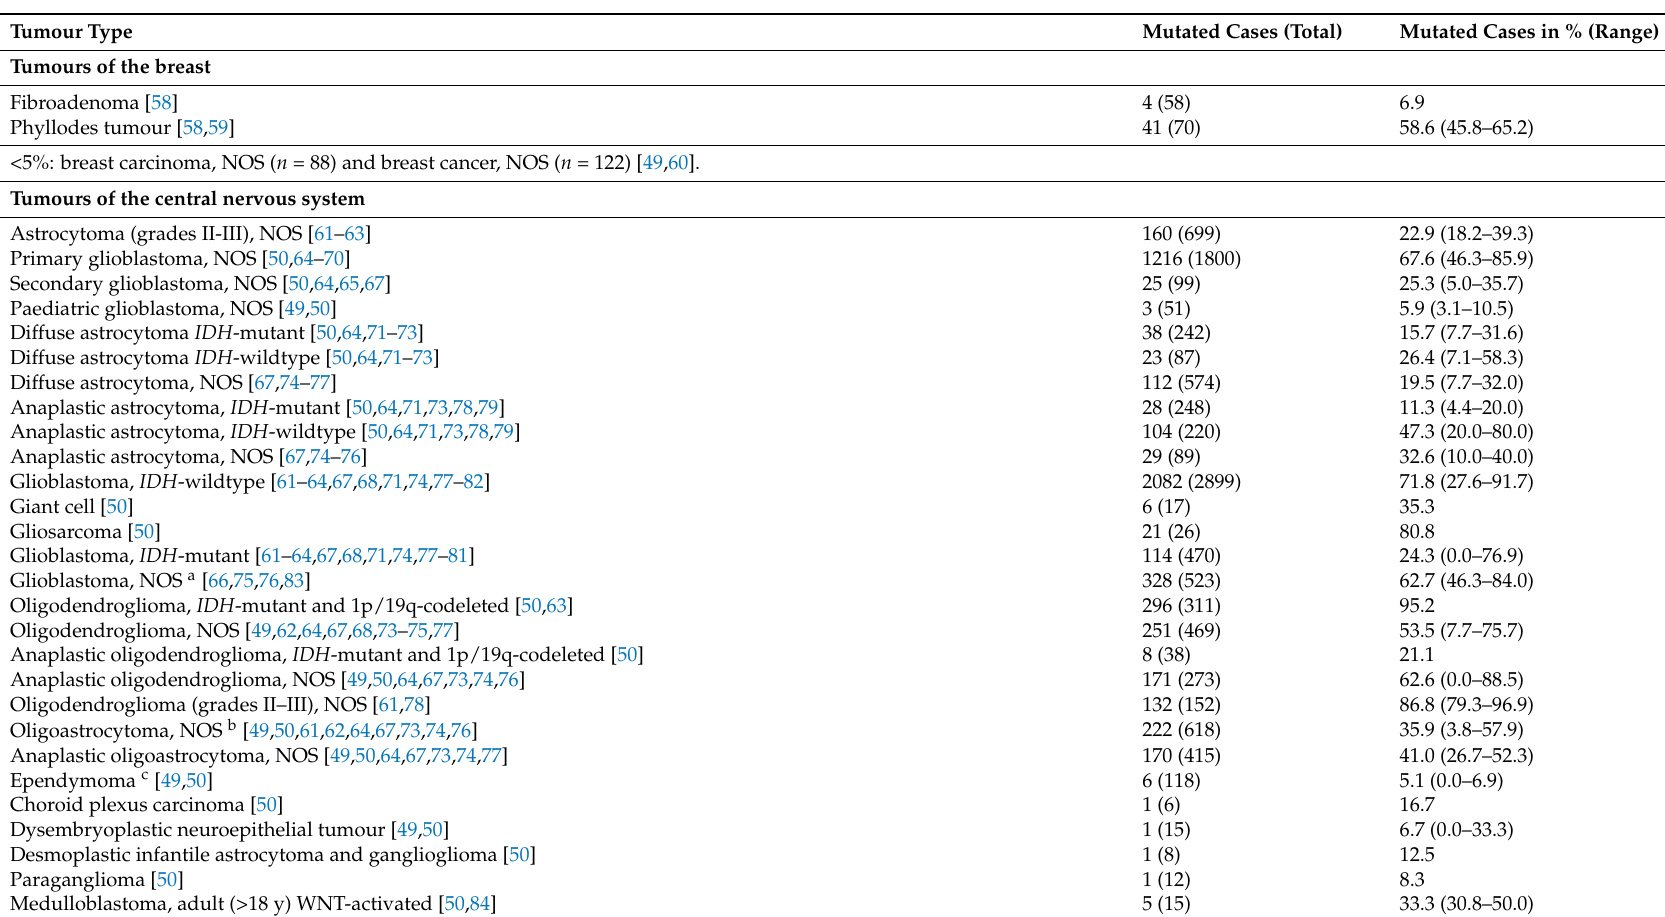
Table 1. Prevalence of TERTp mutations in human tumours. Only the tumour histotypes associated with a frequency of TERTp mutations ≥ 5% appear together with the respective number, percentage, and range of mutated cases. Whenever the tumour histotypes were associated with a low rate of TERTp mutations (<5%) only the total of patients is shown (complete data available in Supplementary Table S1). The designations ‘NOS’ (not otherwise specified) and ‘SNS’ (site not specified) were applied to the tumours in which a specific histotype/site was not